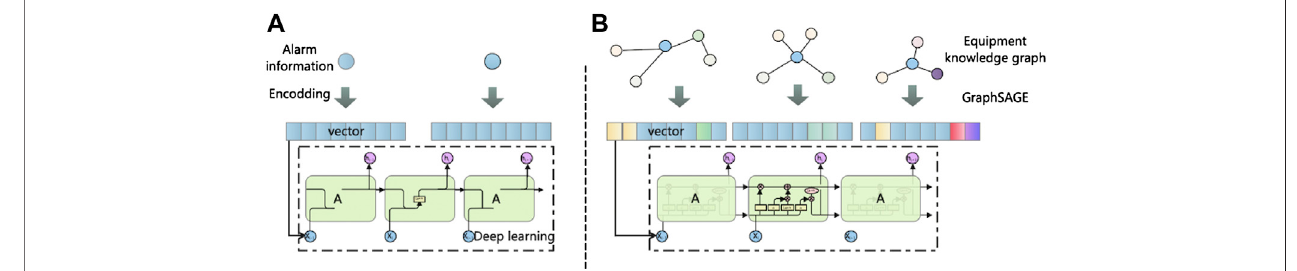
FIGURE 2 | Vectorized model comparison. (A) is a text vectorization model, and (B) adds structural